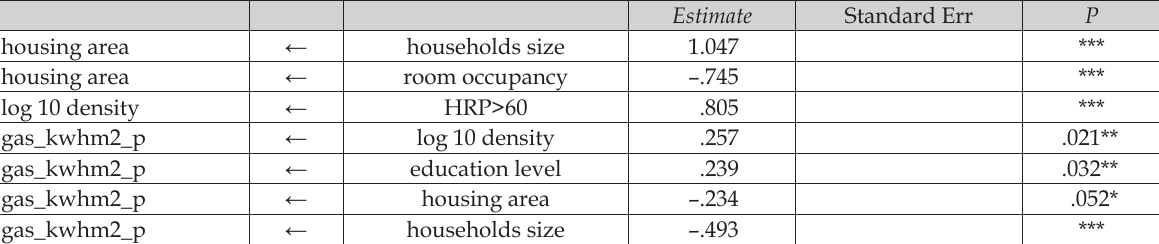
fig. 9. Standardised direct effect for gas consumption per kwh/person.m².y. Table 7. Path analysis: standardised direct effect.